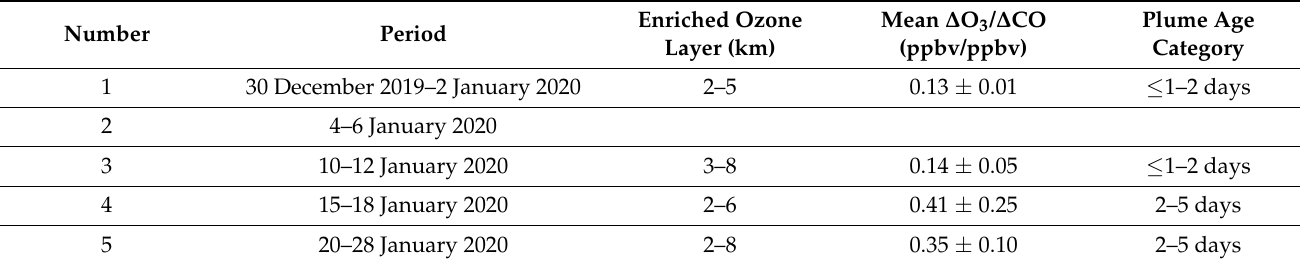
Figure 5. Daily mean evolution of total and partial column of ozone and CO obtained from FTIR observations at Lauder between 22 December 2019 and 31 January 2020. ( a ) Total column of ozone and the anomaly of total column of CO are given in the left panel, while ( b ) the anomaly of ozone (tropospheric and stratospheric) and tropospheric CO are in the right panel. The black and dash lines correspond to ozone monthly mean and the associated standard deviation calculated during the 2010–2018 period. The transport events of the Australian smoke plume detected by IASI are in the grey area. Table 1. Characteristics of the smoke plumes sampled during their transport over Lauder. These characteristics are obtained from FTIR measurements recorded between 22 December 2019 and 31 January 2020. No measurements were recorded during the transport event #2. The period refers to time which the smoke plume is visible over Lauder from IASI observations.